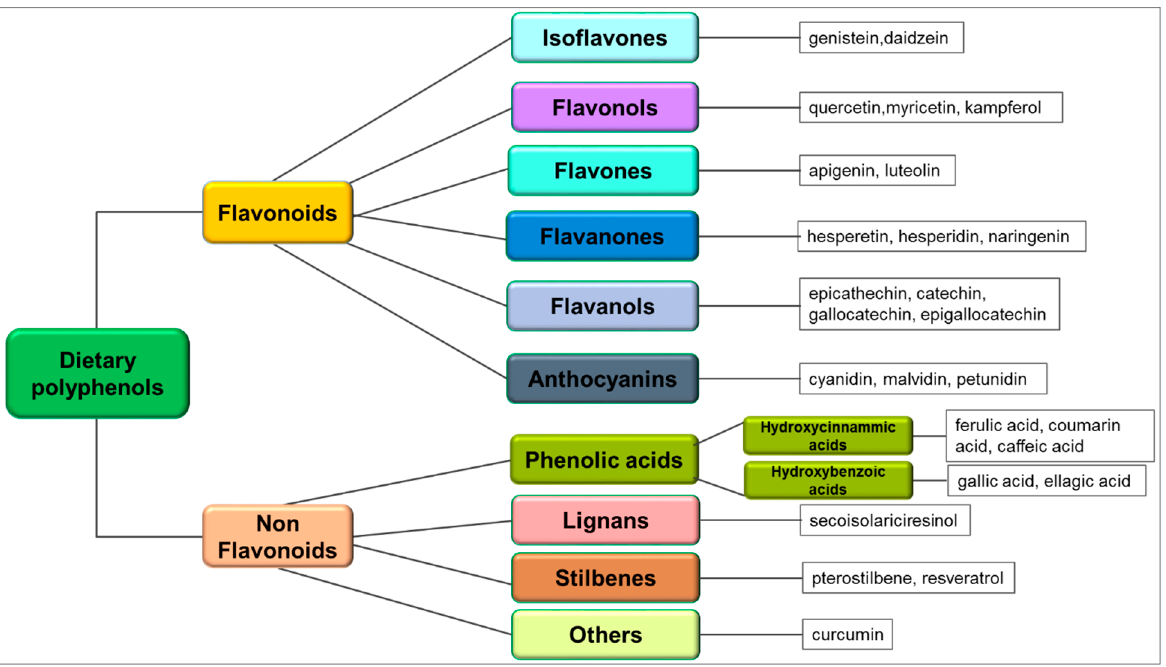
Figure 1. Schematic classification of dietary polyphenols and main relevant phytochemical compounds belonging to the various groups.